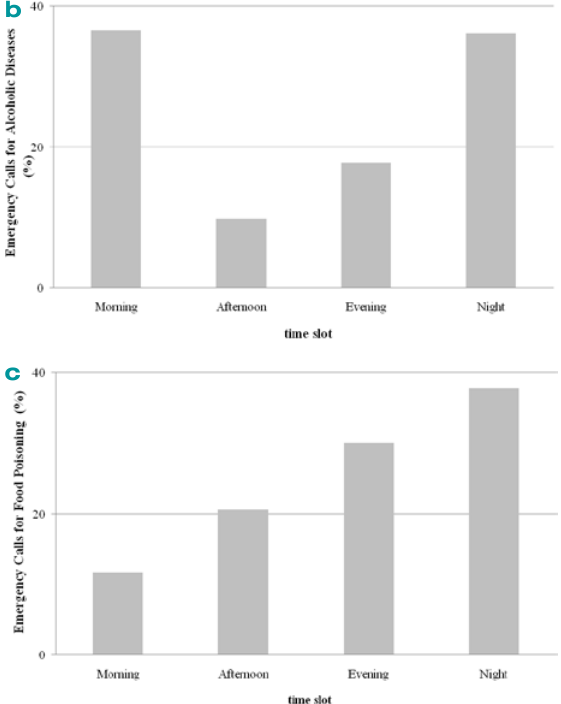
Figure 3 b,c. Time slot analysis of Emergency Calls for Alcoholic Diseases (b) and Food Poisoning